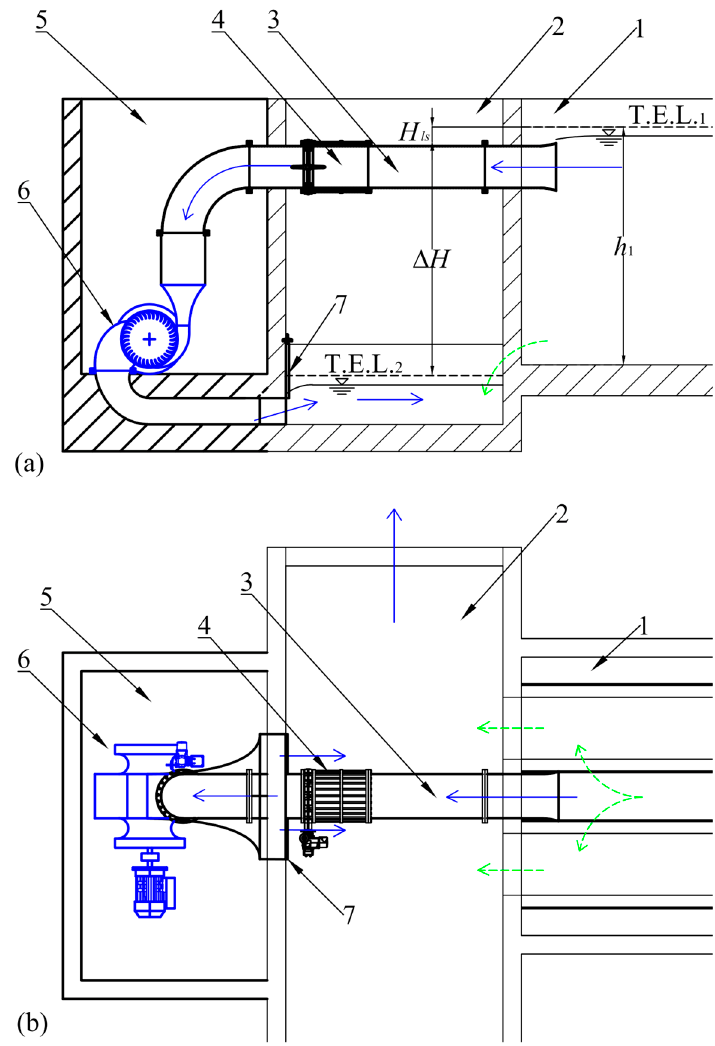
Figure 12. ( a ) Section and ( b ) planimetric view of a UL-PRS type turbine plant, where: 1. Inlet channel; 2. Discharge channel; 3. Suction pipe; 4. Butterfly valve; 5. Underground room; 6. T Hydropower System (blue lines); 7. Gate valve. In thick solid lines, the modifications are proposed for the new solution.